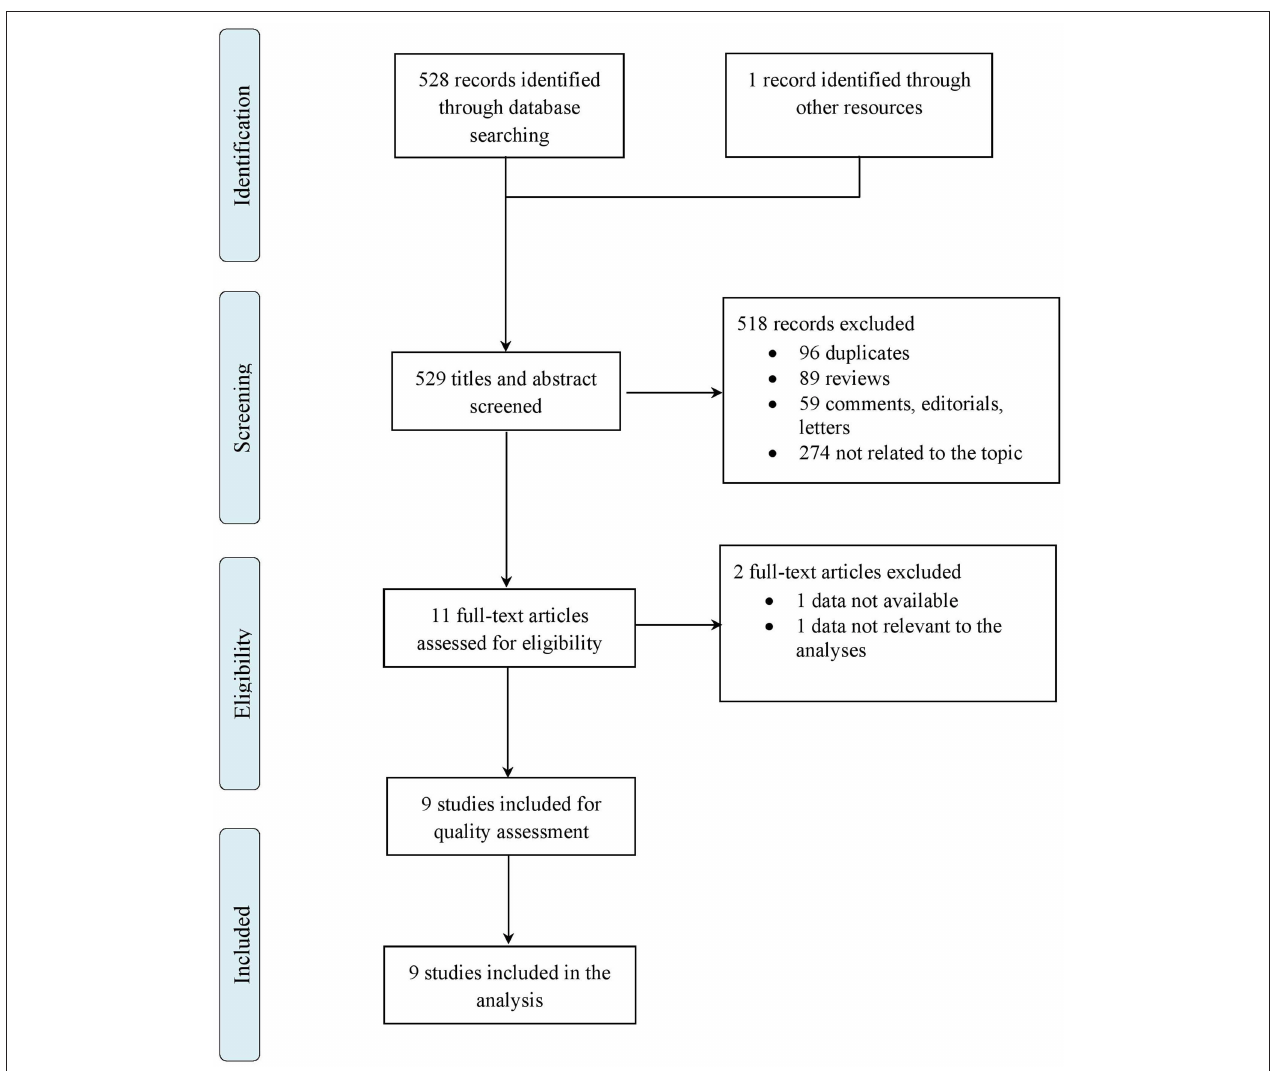
FIGURE 1 | Flow chart of study